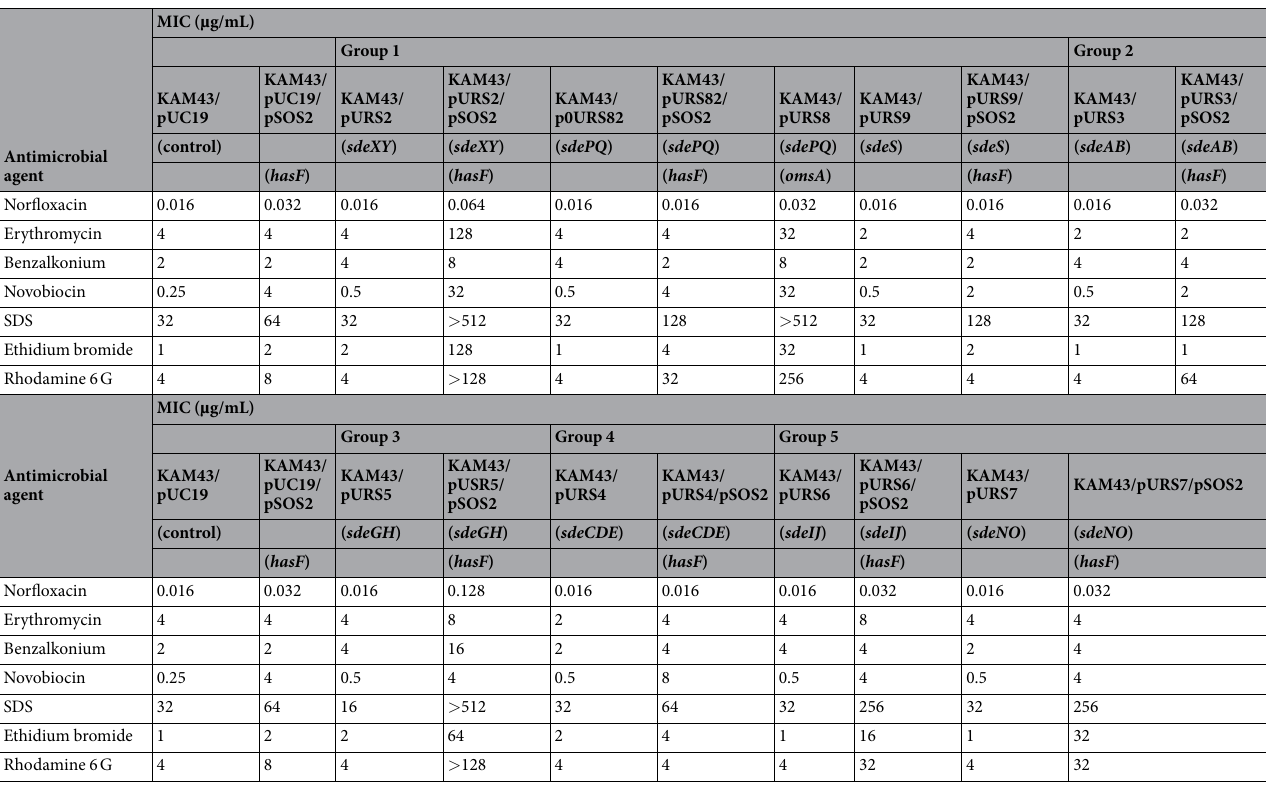
Table 2. Effects of HasF on antimicrobial